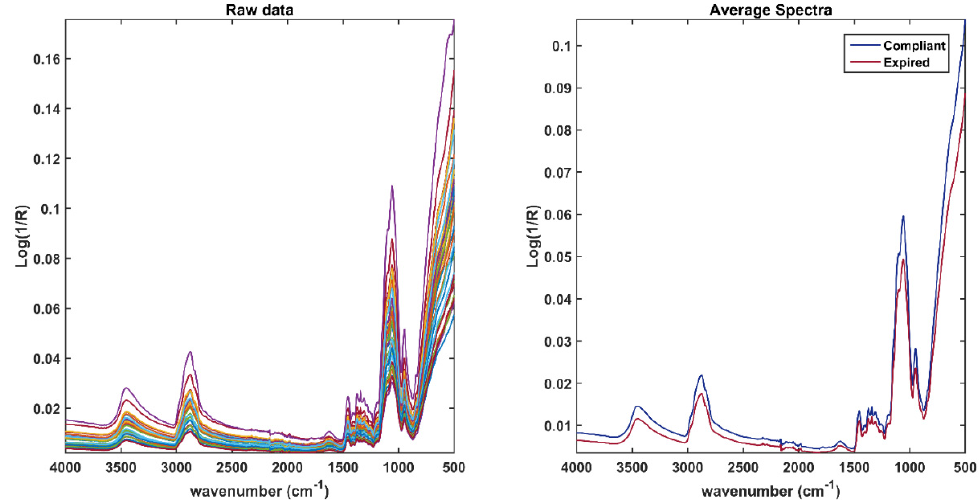
Figure 2. Raw spectra collected on the entire tablet ( left plot); average spectra of expired (red) and compliant tablets ( right plot).